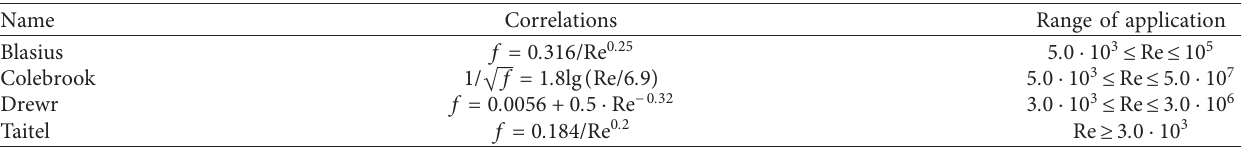
Table 1: Common correlations of wall friction